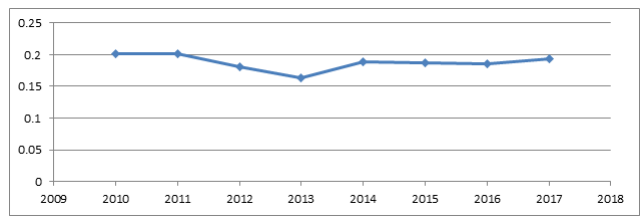
Figure 9. Dynamics of the Gini coefficient of GDP of Russia for 2010–2017.